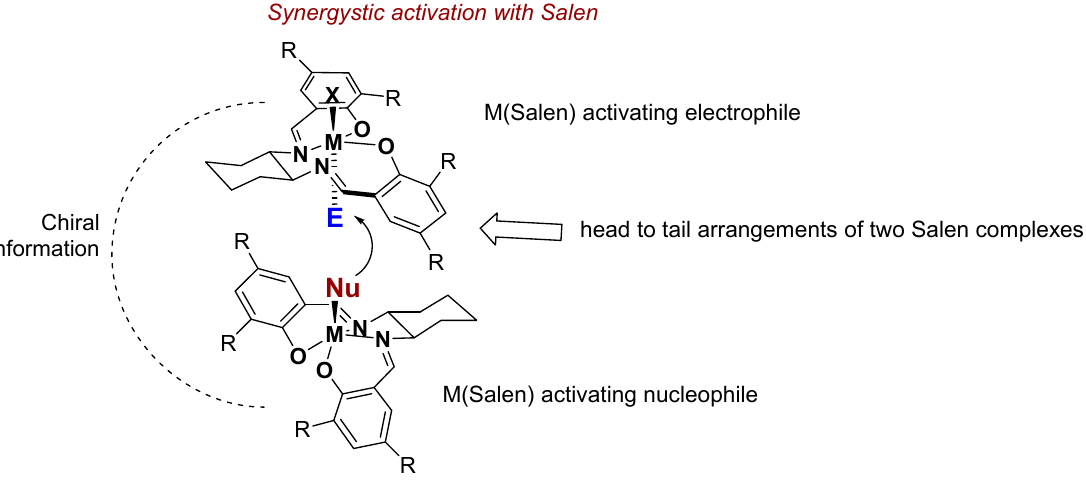
Figure 2. Bifunctional behavior of salen complexes.